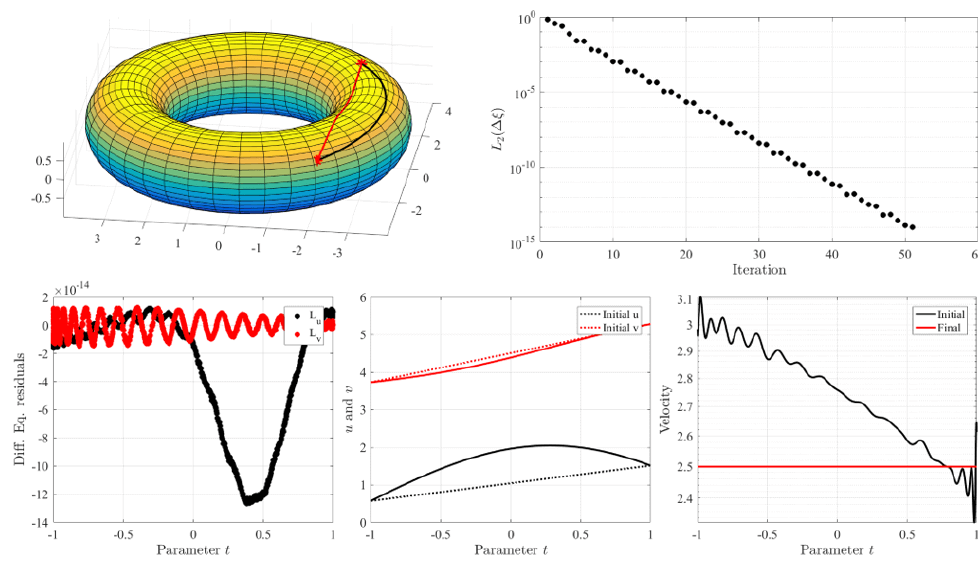
Figure 8. Torus: test